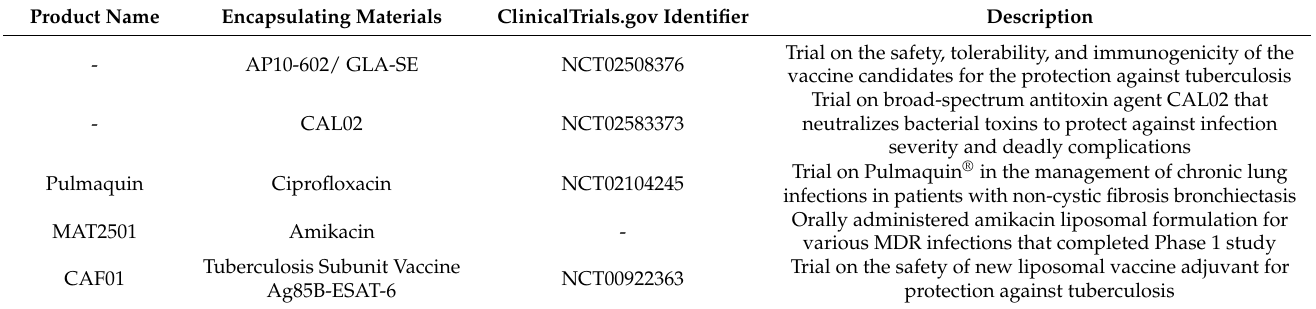
Table 2. Liposomal nanoformulation in clinical development for antibacterial